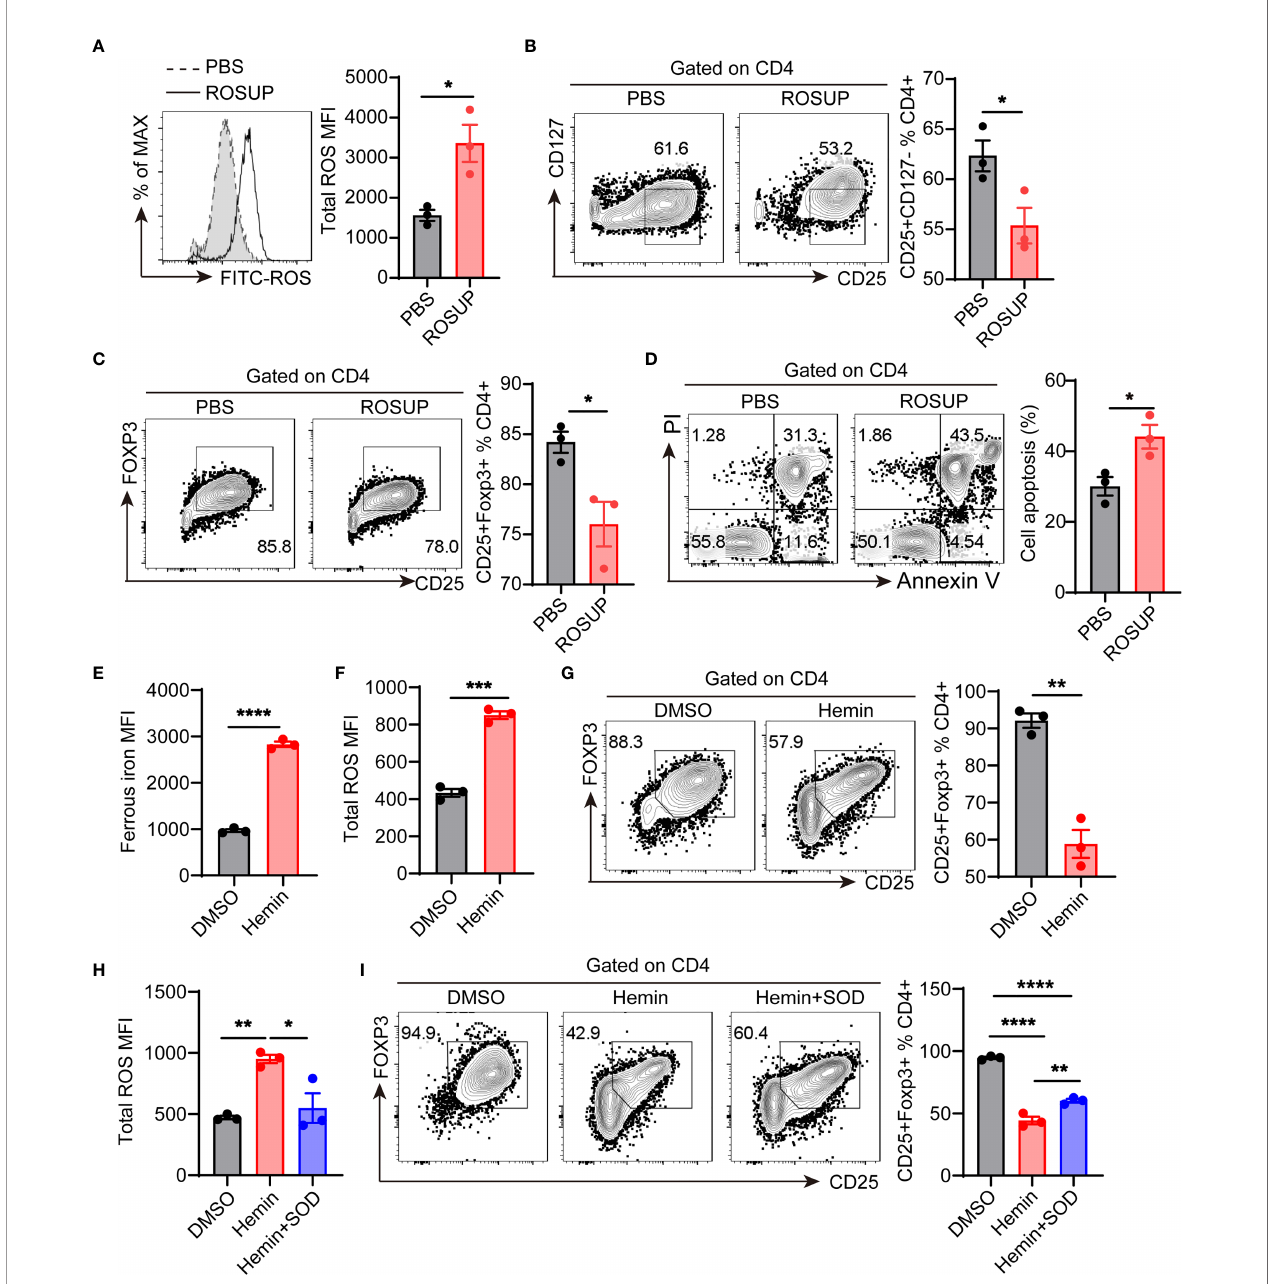
FIGURE 5 | ROS inhibits Treg cell differentiation by promoting apoptosis. Human naive CD4 + T cells were isolated from the peripheral blood of healthy donors and then cultured in Treg cell-polarized conditions with different treatments. After 3 days of Treg cell-polarization, cells were harvested for analysis. (A) Representative fl ow cytometry and quanti fi cation of total ROS in induced Treg cells after ROSUP treatment. (B) Representative fl ow cytometry and quanti fi cation of CD4 + CD25 + CD127 - Treg cells after ROSUP treatment. (C) Representative fl ow cytometry and quanti fi cation of CD4 + CD25 + FOXP3 + Treg cells after ROSUP treatment. (D) Representative fl ow cytometry and quanti fi cation of apoptosis in cells treated with ROSUP. Annexin V + PI + is determined as apoptosis. (E, F) Quanti fi cation of ferrous iron (E) and ROS (F) in induced Treg cells treated with DMSO or Hemin. (G) Representative fl ow cytometry and quanti fi cation of CD4 + CD25 + FOXP3 + Treg cells in cells treated with DMSO or Hemin. (H) Quanti fi cation of ROS in induced Treg cells treated with DMSO, Hemin, or Hemin plus SOD. (I) Representative fl ow cytometry and quanti fi cation of CD4 + CD25 + FOXP3 + Treg cells in cells treated with DMSO, Hemin, or Hemin plus SOD. ****P < 0.0001, ***P < 0.001, ** P < 0.01, *P < 0.05 (unpaired two-tailed Student ’ s t -test for A – G ; one-way ANOVA and Tukey ’ s multiple comparisons test for H and I ). Data are shown as mean ± S.E.M. Two independent experiments were performed (n =